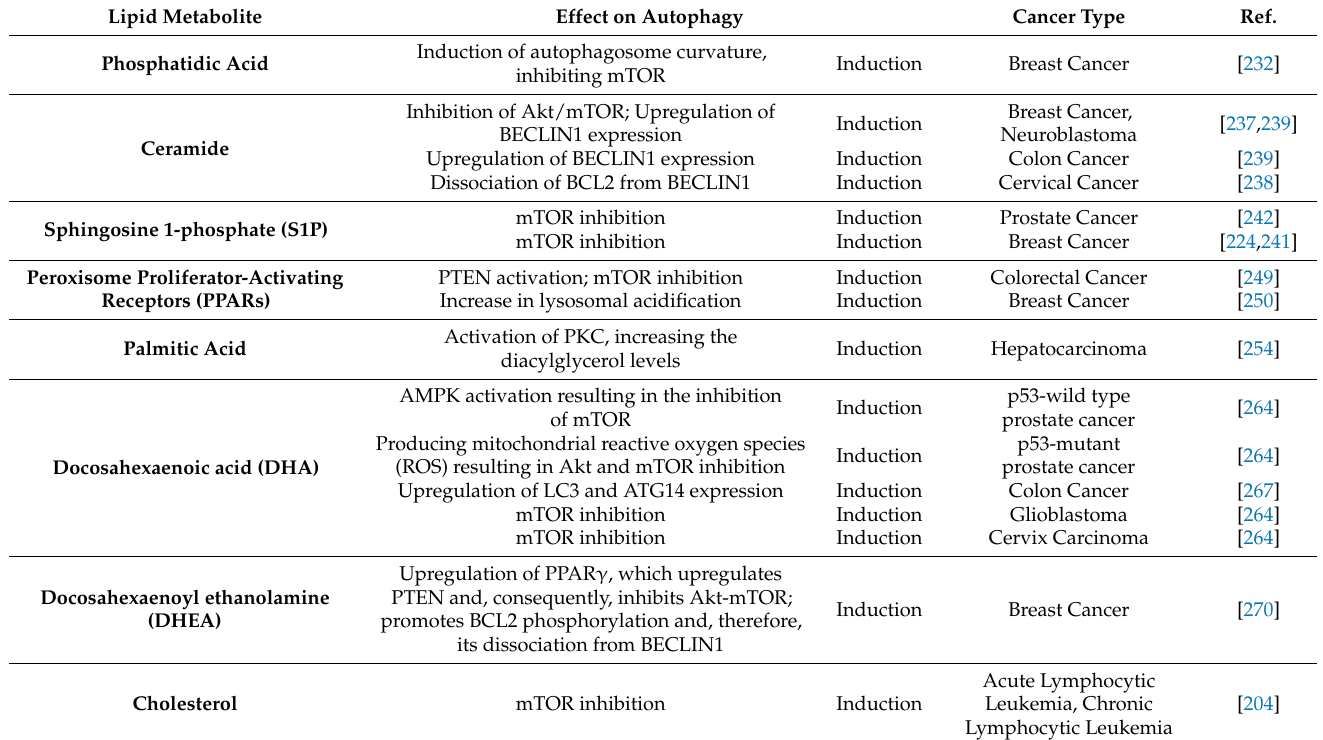
Table 3. Regulation of autophagy by lipid metabolites during